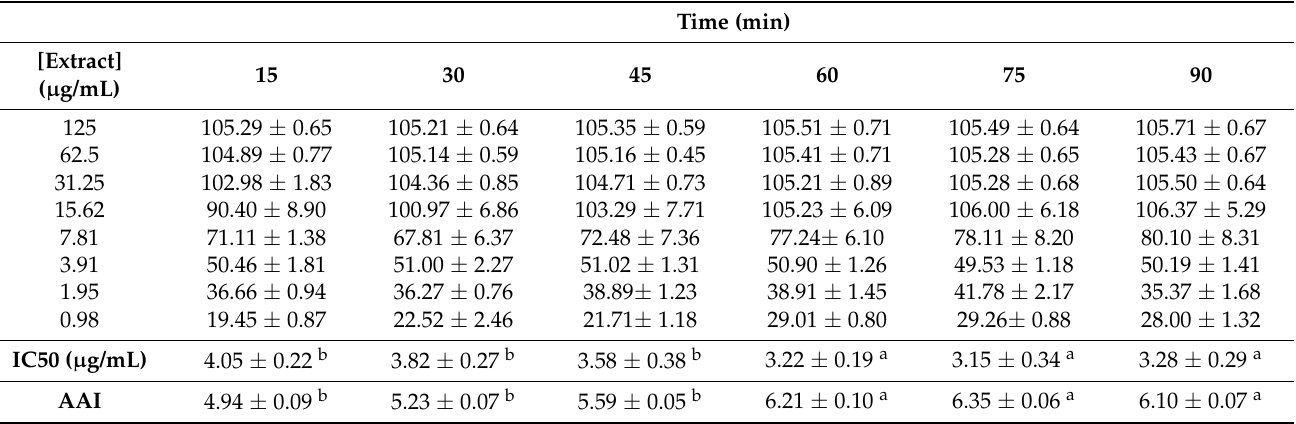
Table 3. Antioxidant activity against DPPH radical of ethanolic extract of Origanum vulgare ssp. vulgare . Results are expressed as percentage of inhibition (%), IC50 ( µ g/mL) values and activity index (AAI). Time